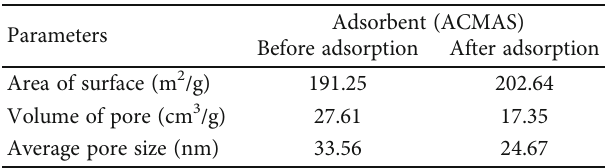
Figure 4: Plot for BET analysis: (a) CV adsorption-desorption plot for isotherms, (b) plot for surface area, and (c) distribution of pore size for BJH desorption. Table 1: BET analysis parameters.